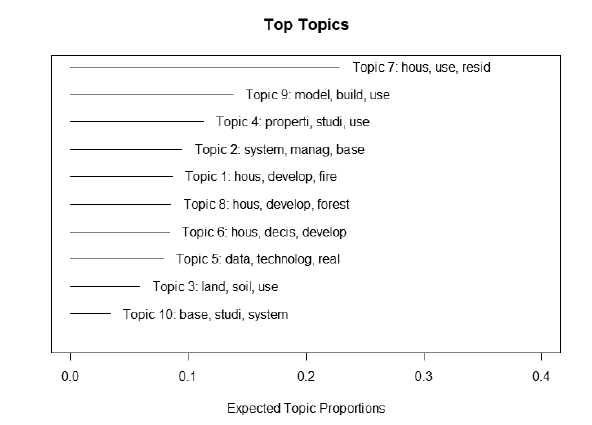
Figure 7. Generated topic